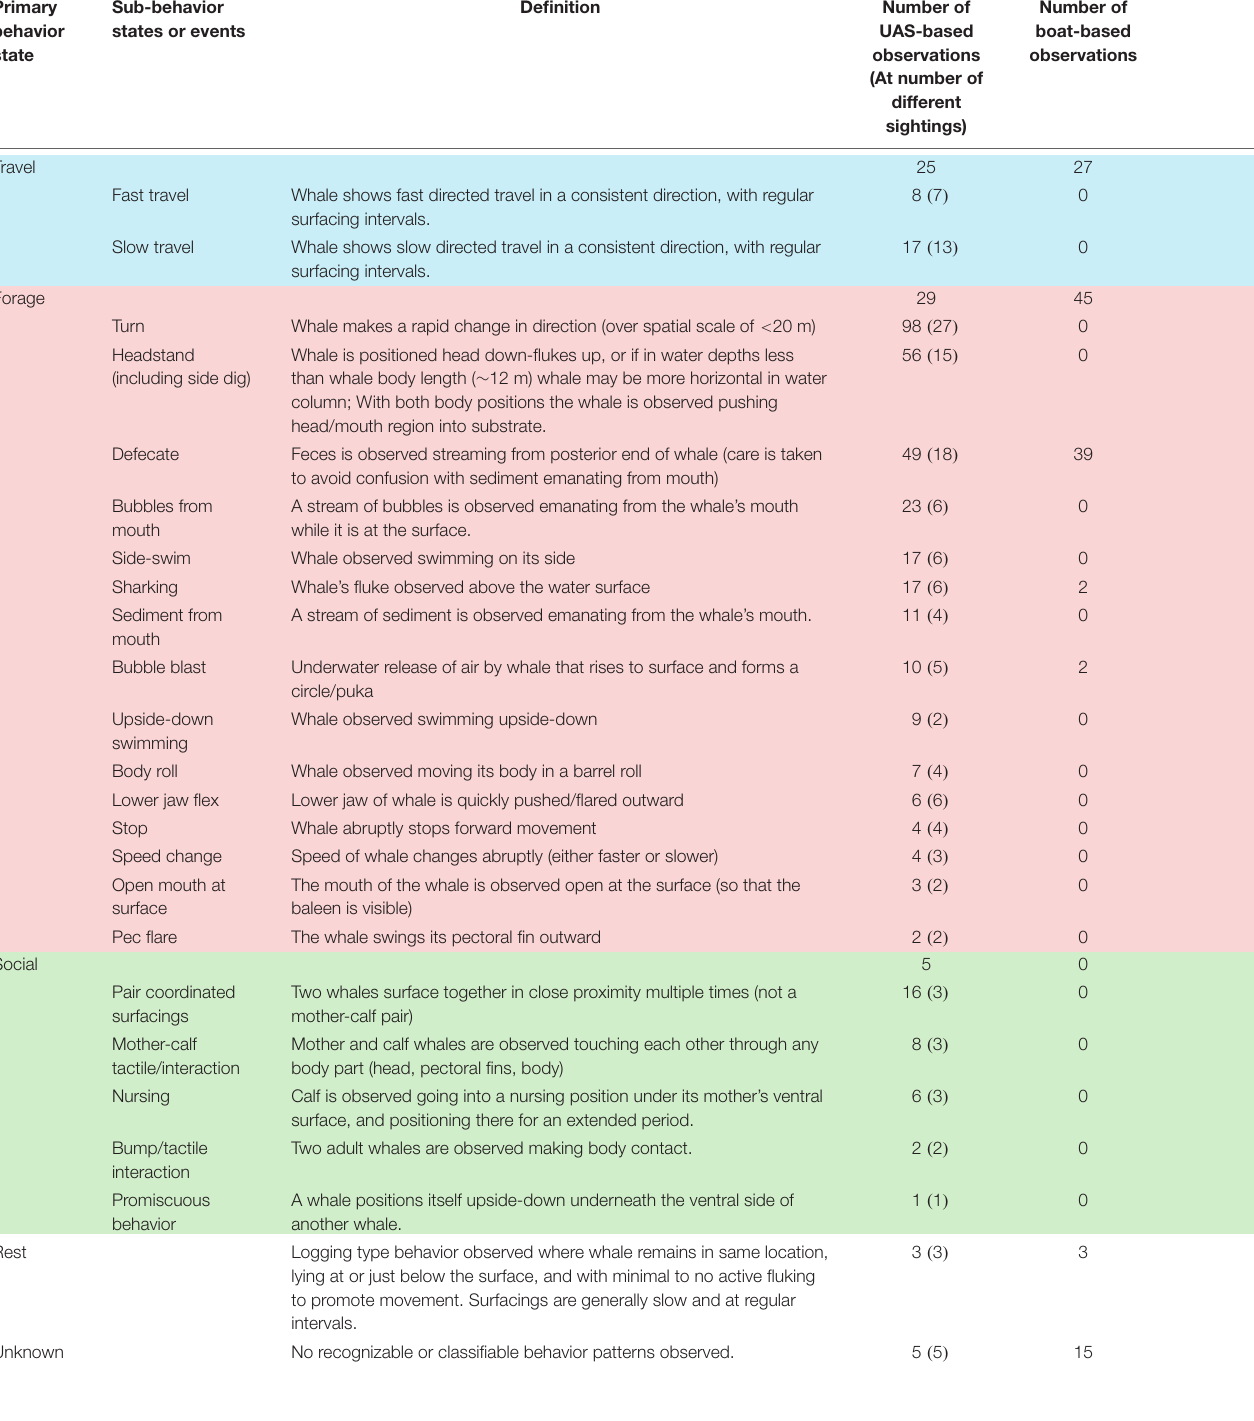
TABLE 1 | Description of whale sub-behavior states and events that were identified in Unmanned Aerial System (UAS) video analysis, and used to classify Primary behavior state of each sighting. No sub-behavior states or events were identified for the primary behavior states of Rest and Unknown. The right columns tabulate the number of times each behavior was observed in UAS videos (multiple observations can occur in one sighting), the number of sightings each behavior was observed at, and the number of times the behavior was observed from the boat. Primary behavior